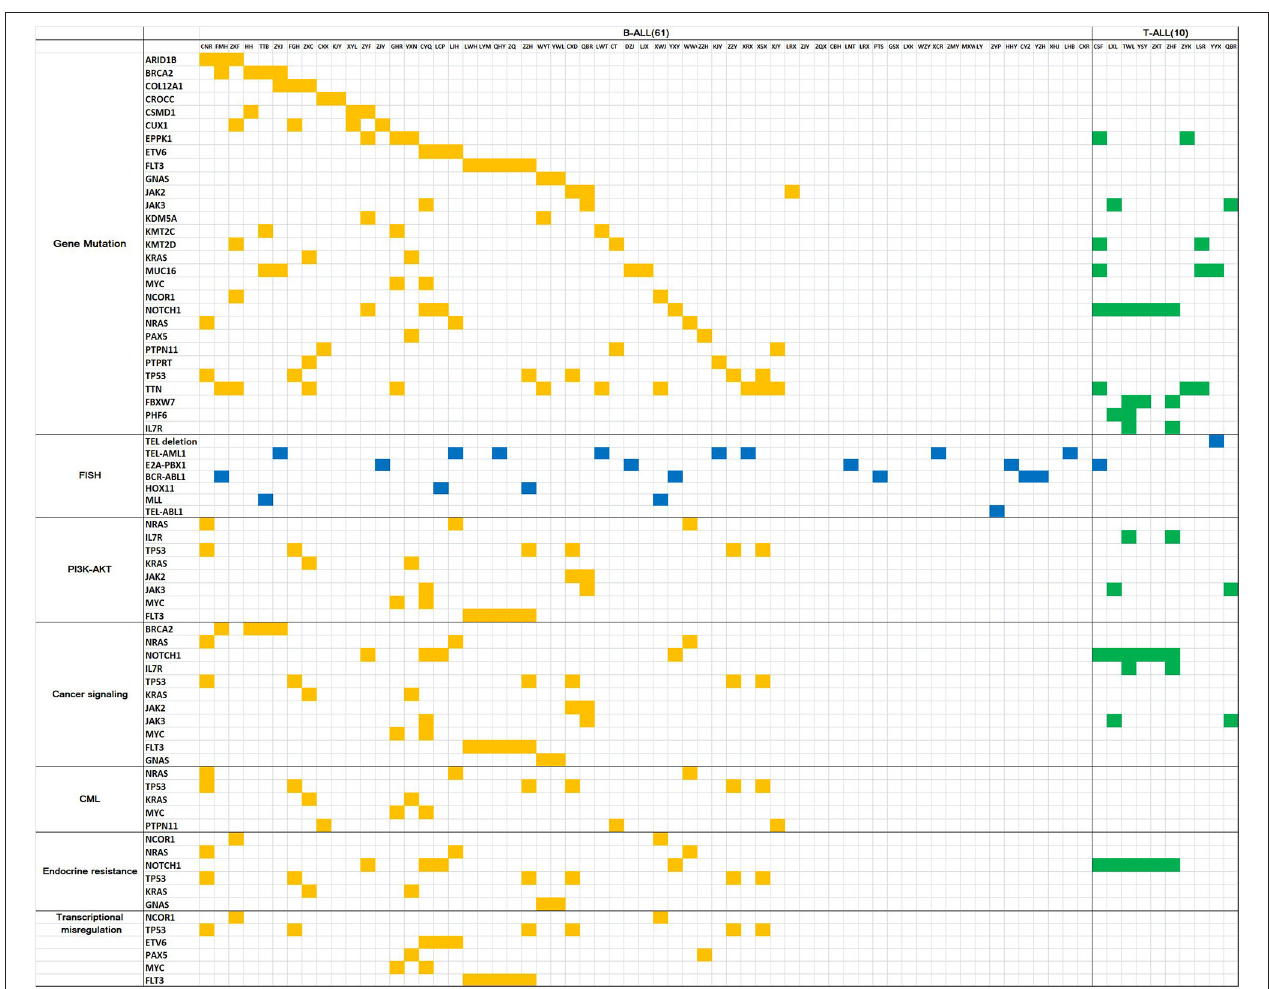
FIGURE 1 | Gene mutation map for acute lymphoblastic leukemia. The horizontal columns represent the patient number, the vertical columns represent the gene name, the yellow squares represent positive gene mutation in B-ALL, the green squares represent positive gene mutationin T-ALL, the blue squares represent positive FISH